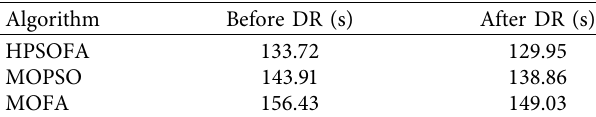
Figure 8: Optimal day-ahead scheduling in scenario 2. Table 5: Experimental